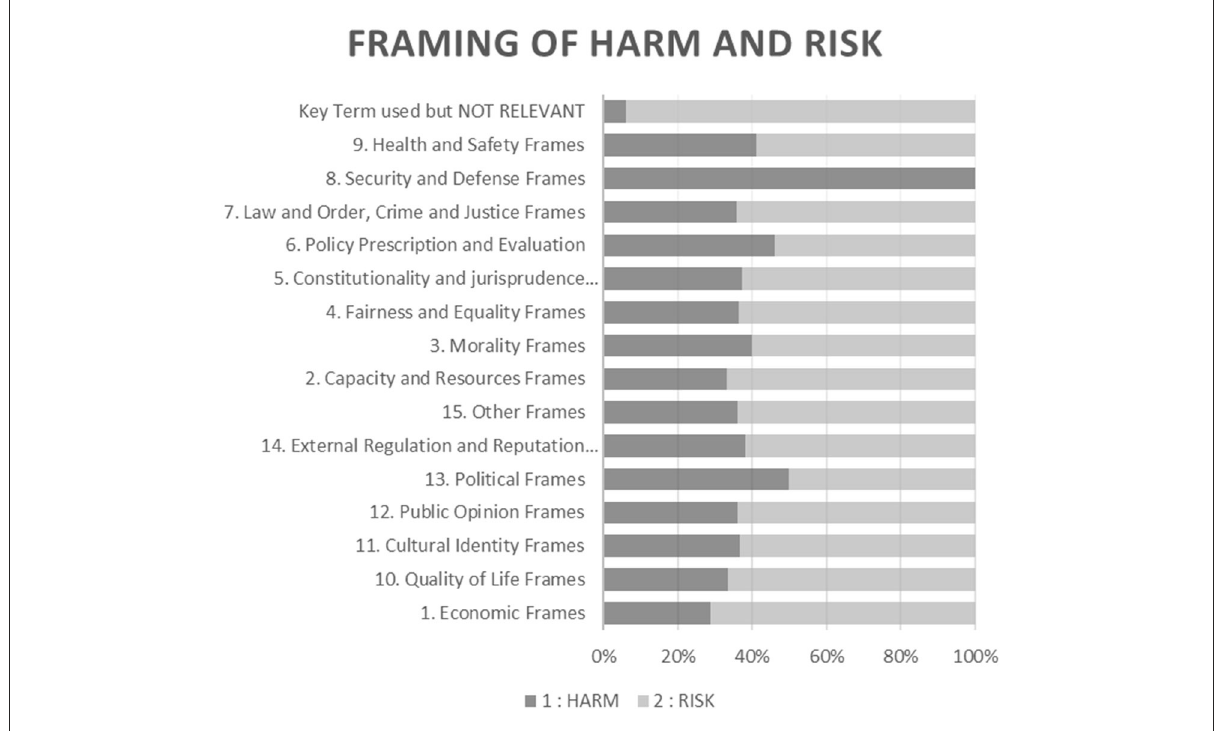
FIGURE1 Split of content between harm and risk across policy